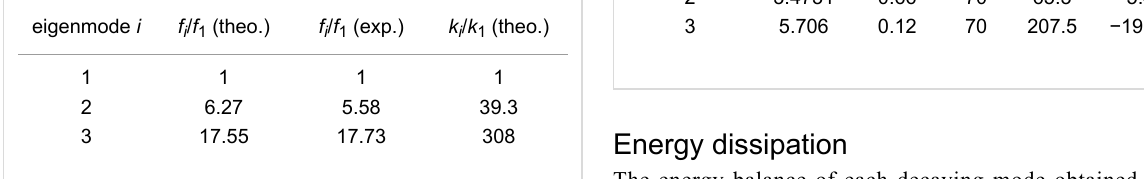
Table 1: Calculated free flexural frequencies [16] and experimental frequencies of the excited flexural modes given in units of the first free flexural frequency f 1 = 11.7 kHz. The theoretical scaling for the force constants ( k i ) is reported for each flexural mode [1]. eigenmode i f i / f 1 (theo.) f i / f 1 (exp.)